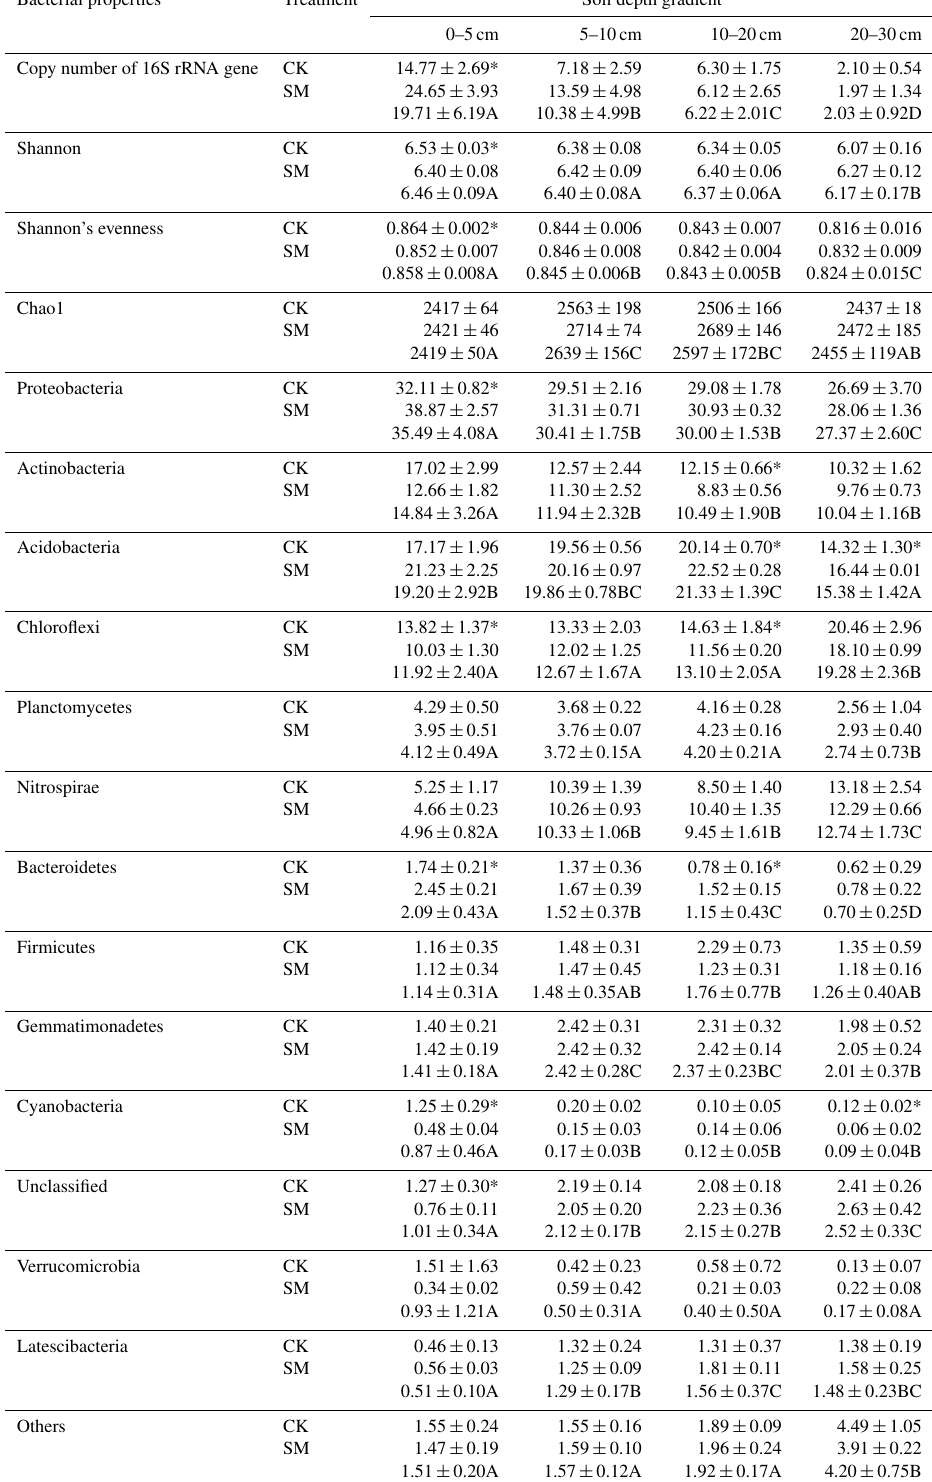
Table 4. Soil bacterial properties at different soil depths under SM and CK treatment. CK, no-till with straw removal; SM, no-till with straw mulching. Data are means ± standard deviations, n = 3. Different capital letters indicate significant differences ( P < 0.05) among the four depths; ∗ indicates significant differences ( P < 0.05) among the two straw management strategies within each depth (Duncan’s